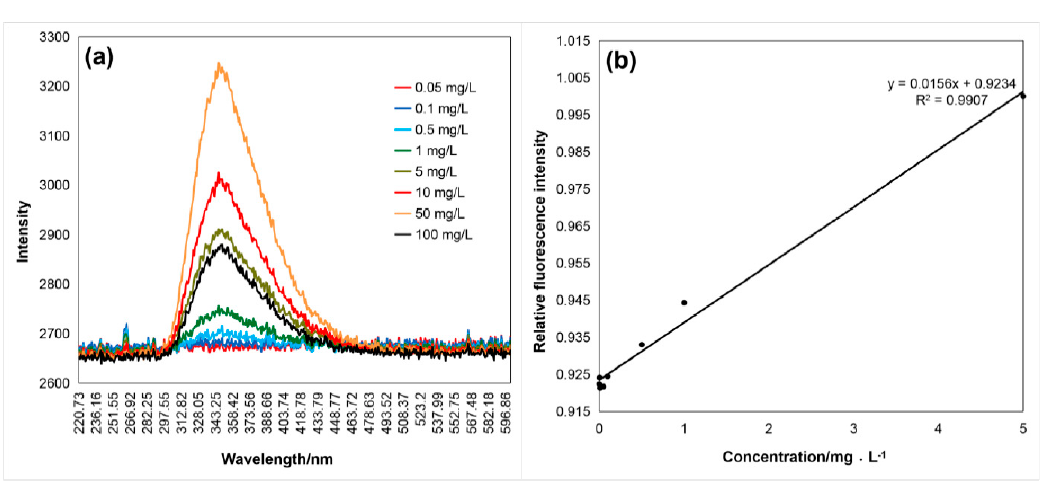
Figure 7. ( a ) Fluorescence spectrum ( λ max3 = 280 nm) of phenylalanine excited by the 266 nm laser, and ( b ) the relation curve between the normalized fluorescence peak intensity, I F3 , and the phenylalanine concentration, C 3 , of 0.1 mg/L –1 g/L with a coefficient of determination of 0.9767.